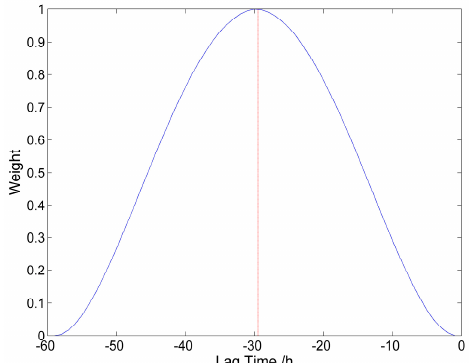
Figure 5. The weighting curve: the weight curve is shifted to the left, and the right-most value is zero, indicating the current time.